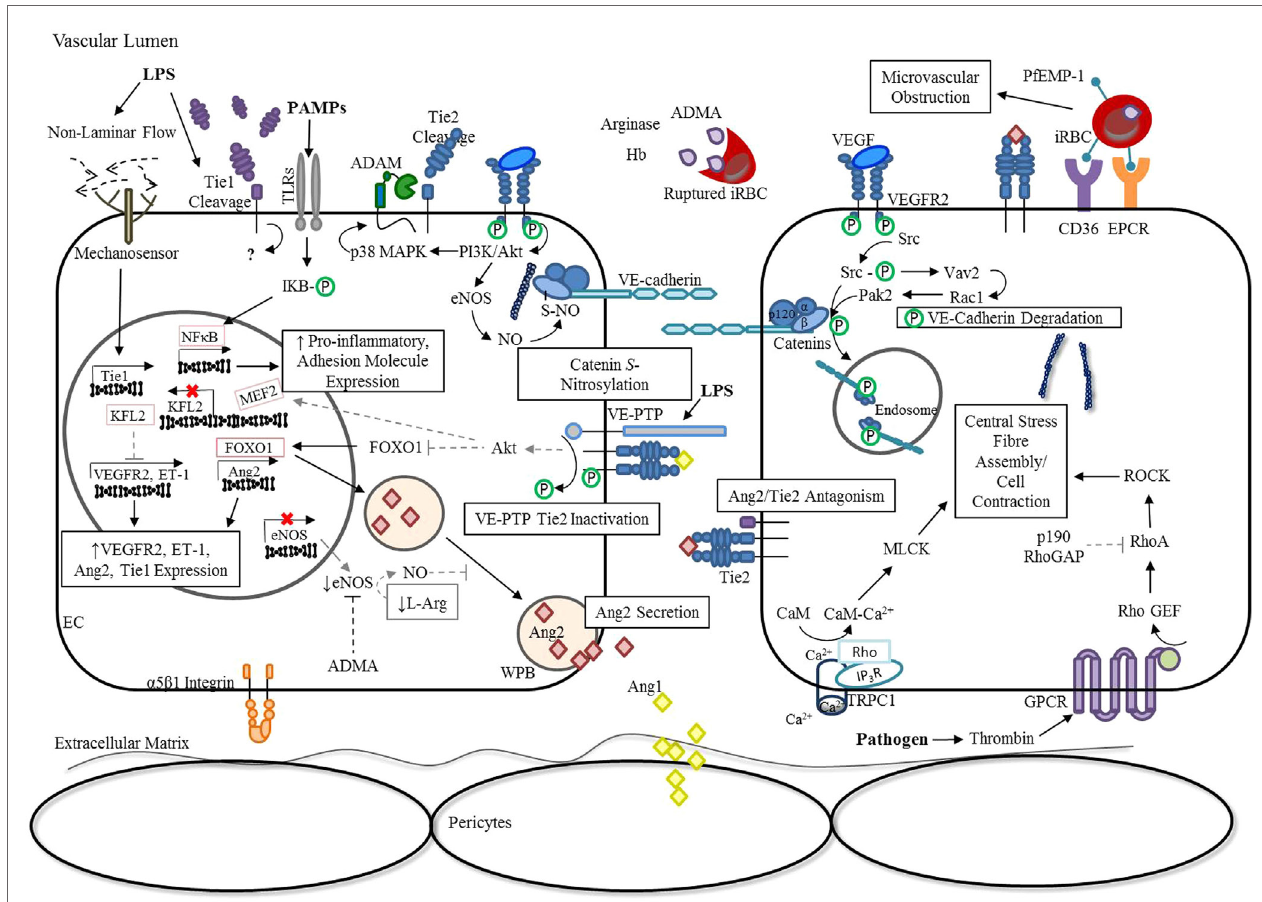
FigURe 2 | Endothelial activation: dysregulation of Ang/Tie signaling during severe infection. In response to inflammation, ECs release Ang2 from WPB into the vascular lumen, tipping Ang2:Ang1 ratios in favor of Ang2 (21). The release of ADMA, arginase, and hemoglobin from ruptured Plasmodium falciparum infected erythrocytes additionally decrease the availability of NO, enhancing WPB exocytosis (61, 62). Simultaneously, the presence of infection or TNF- α leads to Tie1 inactivation by ectodomain cleavage, thereby reducing the agnostic activity of Ang1 and promoting the antagonistic action of Ang2 (14, 15). Under conditions of hypoxia, such as an infection-induced reduction in laminar flow, VE-PTP expression is up-regulated (43), and a negative feedback loop is triggered that limits Tie2 activation by enhancing its association with VE-PTP (42). Interestingly, the transcription of Tie1 is also up-regulated in response to reduced laminar flow, despite ectodomain cleavage, suggesting an unknown role for the intracellular tyrosine kinase domain in signaling under these conditions (63). The resulting inactivation of Tie2 during infection and/or inflammation promotes FOXO1 transcriptional activity, thereby increasing Ang2 expression (15, 18, 20). The reduction in KFL2 expression associated with Tie2 inactivation stimulates VEGF-induced monocyte adhesion and vascular permeability (27, 64, 65). Furthermore, increased VEGFR2-signaling during infection leads to the activation of downstream pathways, such as PI3K/Akt and Src. Consequently, p38 MAPK-dependent activation of the protease, ADAM-15, induces Tie2 shedding and prevents its downstream signaling (66). In parallel, VEGFR2 activation of eNOS and Src further disrupt adherens junction complexes through S- nitrosylation of β -catenin (67) and phosphorylation of VE-cadherin (68, 69), respectively. Pathogens can indirectly lead to the activation of RhoA through GPCRs (70), for example, thrombin binding of protease-activated receptors (71, 72), to promote the formation of actin stress fibers that increase centripetal tension throughout the cytoskeleton (73). Furthermore, limited Tie2 activation during infection prevents p190RhoGAP inhibition of RhoA (35), and subsequent coupling of IP 3 R and TRPC1 to form a Ca 2 + channel in the plasma membrane (74). This rise in intracellular Ca 2 + leads to CaM-dependent activation of MLCK to further support EC contraction (35, 75). Lastly, TLR activation by PAMPs triggers the downstream activation of NF- κ B to induce the expression of pro-inflammatory cytokines and adhesion molecules (76). This generates a positive feedback mechanism for endothelial destabilization, until infection and the associated inflammatory response are resolved (77). Abbreviations: ADAM-15, disintegrin and metalloproteinase domain-containing protein 15; ADMA, asymmetric dimethylarginine; Ang1, angiopoietin-1; Ang2, angiopoietin-2; Ca 2 + , calcium; CaM, calmodulin; CD36, cluster differentiation 36; EC, endothelial cell; eNOS, endothelial nitric oxide synthase; EPCR, endothelial protein C receptor ET-1, endothelin-1; FOXO1, forkhead box protein O1; GPCR , G-protein-coupled receptor; iRBC, Plasmodium -infected red blood cell; IP 3 R, inositol triphosphate receptor; IQGAP, IQ motif containing GTPase activating protein; KLF2, Krüppel-like factor-2; LPS, lipopolysaccharide; mDia, mammalian diaphanous; MEF2, myocyte enhancer factor-2; miR-30, microRNA-30-5p; MLCK, myosin light-chain kinase; NF- κ B, nuclear factor- κ B; NO, nitric oxide; p190RhoGAP, p190Rho GTPase-activating protein; p38 MAPK, p38 mitogen-activated protein kinase; PAMPs, pathogen- associated molecular patterns; PI3K, phosphoinositide triphosphate kinase; Rac1, RAS-related C3 botulinum toxin substrate 1; Rap1, Ras-related protein 1; RhoA, Ras homolog gene family, member A; RhoGEF: Rho guanine nucleotide exchange factor; S-NO, S- nitrosylation; Src, proto-oncogene tyrosine-protein kinase; TRPC1, transient receptor potential channel-1; VE-cadherin, vascular endothelial-cadherin; VEGF, vascular endothelial growth factor; VEGFR2, vascular endothelial growth factor receptor 2; VE-PTP, vascular endothelial protein tyrosine phosphatase; WPB, Weibel-Palade Body; P, phosphorylation.